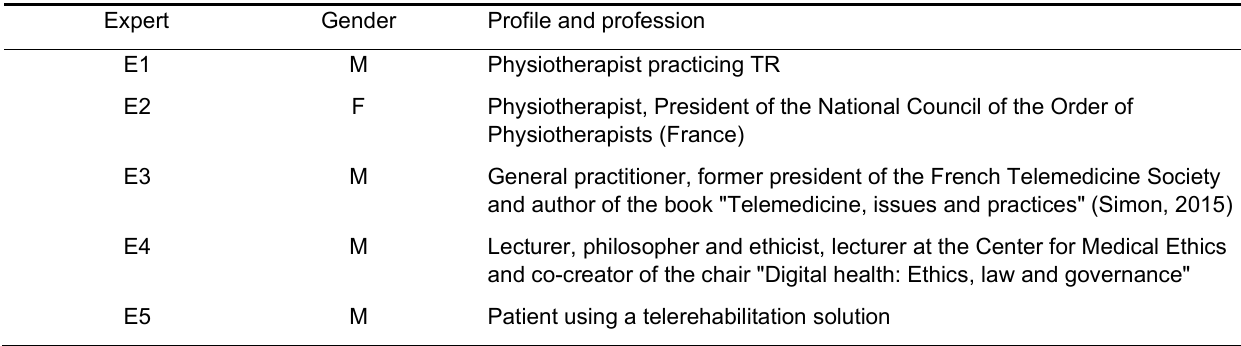
Characteristics of Included